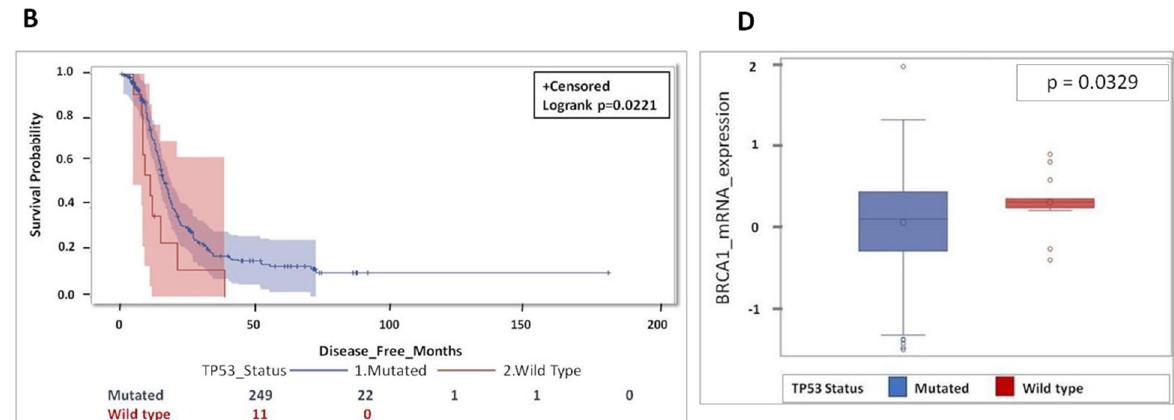
Figure 2. Patients bearing a TP53 -mutated tumor show better prognosis compared to TP53 wild type. ( A ) Overall survival for HGSOC patients according TP53 status. ( B ) Disease-free survival (DFS) for HGSOC patients according TP53 status. ( C ) Box-plot showing the distribution of BECN1 expression according TP53 status. ( D ) Box-plot showing the distribution of BRCA1 expression according TP53 status. (Note that for OS data were not available for 1 patient (mutated group 1 pt: 302 pt’s total n = 303 mutated pt’s) while for DFS data were missing for 56 patients (mutated group 54 pt: 249 pt’s+ wild type group 2 pt’s: 11 pt’s; total n = 316 pt’s), respectively).